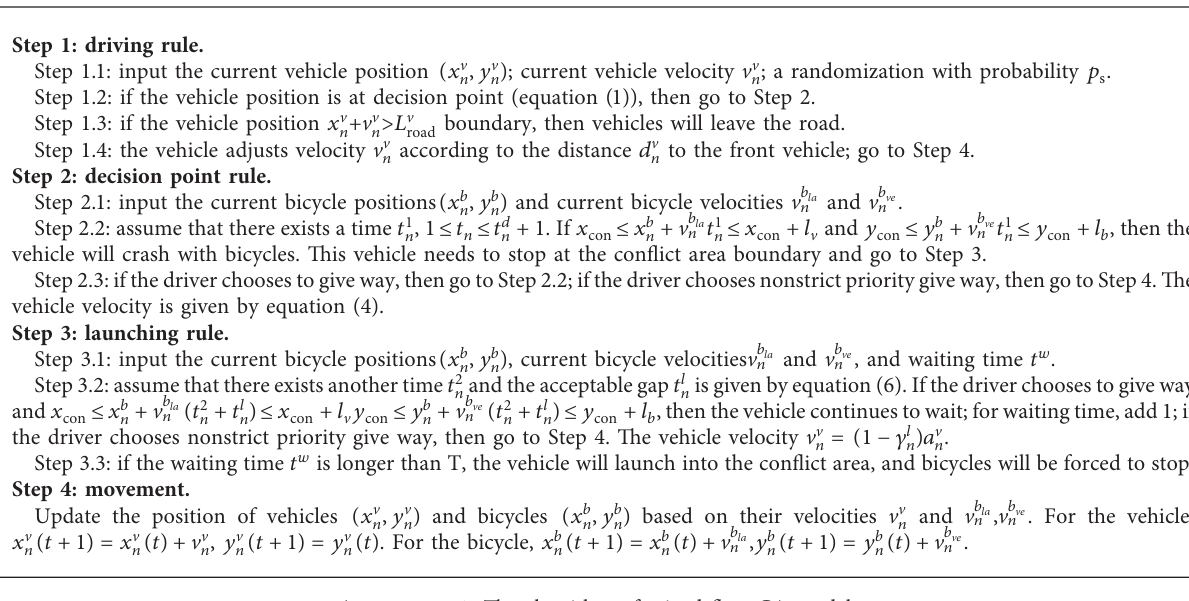
A LGORITHM 1: The algorithm of mixed-flow CA model.